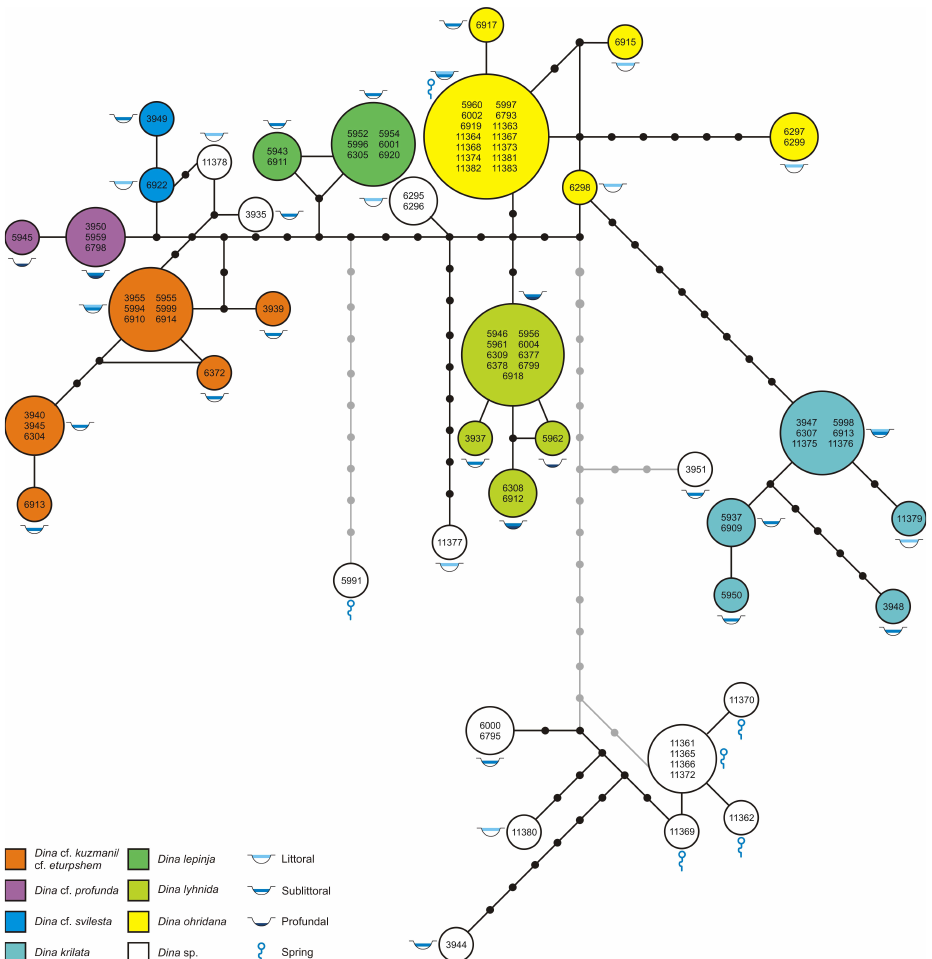
Fig. 4. Statistical parsimony haplotype network of specimens of the Ohrid Dina flock based on the mitochondrial COI gene (connection limit 95%). Haplotypes are colour-coded according to taxa (DNA voucher numbers are provided inside the circles; see Table 1 for details). Areas of circles representing the haplotypes found are proportional to the number of specimens sharing the respective haplotype. Missing haplotypes are indicated by black dots. The grey lines show the connections among sub-networks when reducing the TCS connection limit to 90%. Major habitat types are indicated by